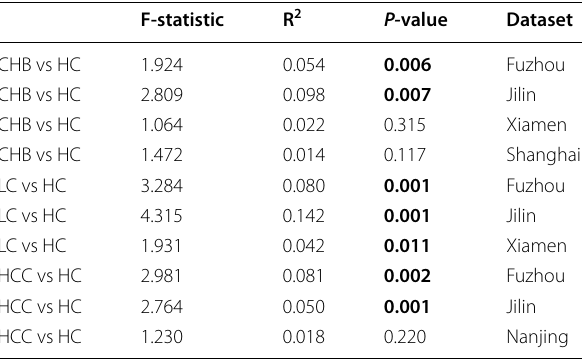
R 2 indicated the percentage of explained variance occupying in the total by group parameters, P -value indicated the significance and bold fonts indicated statistically significant differences between